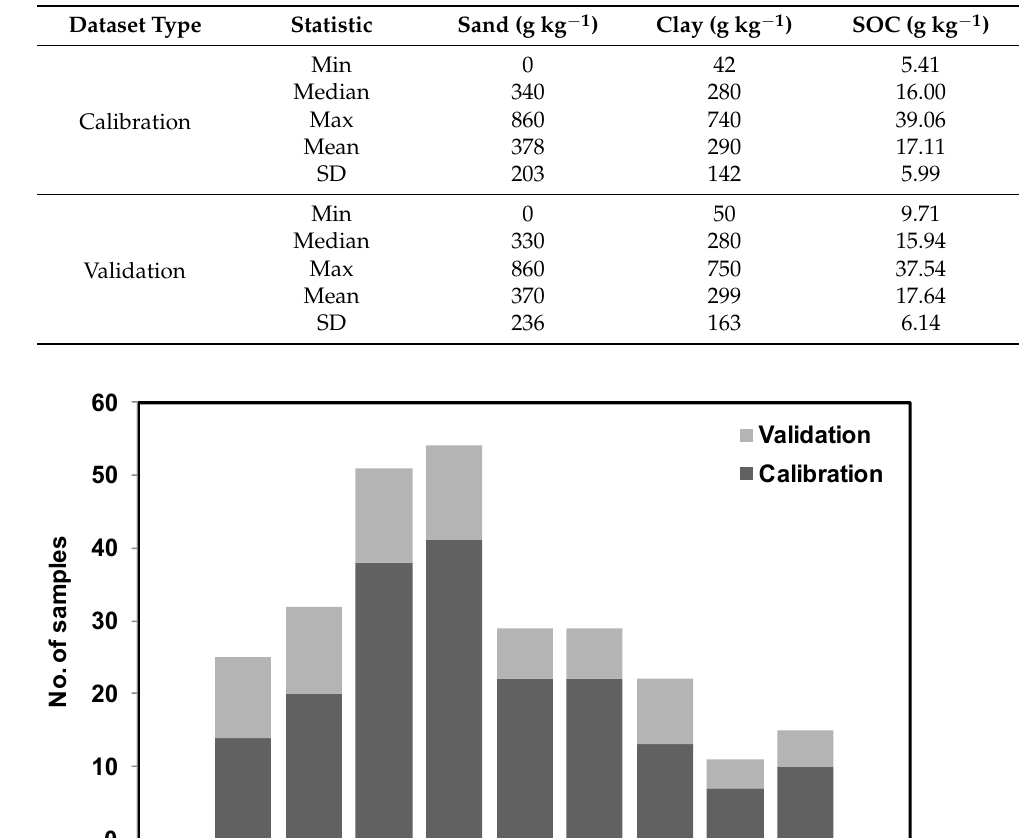
Figure 7. Illustration of distribution of clay content using stacked histogram with two categorical variables (calibration data and validation data).